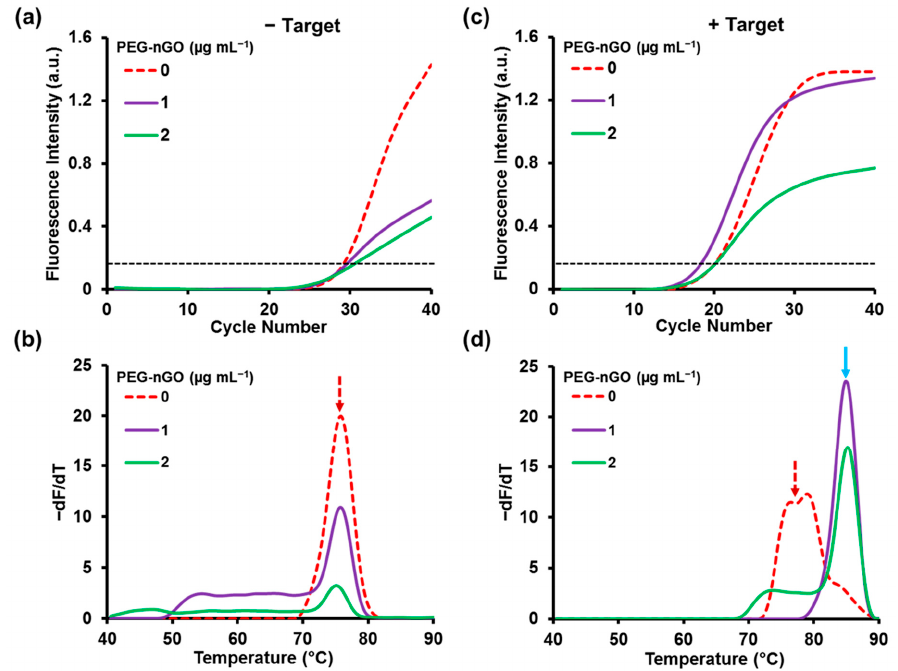
Figure 3. Effect of PEG-nGO on specificity of EG-based qPCR. ( a ) Real-time fluorescence monitoring of qPCR-amplified products in the absence of target RNA (IFZ B) with various PEG-nGO concentrations (0, 1 and 2 μ g mL − 1 ). ( b ) Melting curve analysis of qPCR-amplified products in the absence of target RNA with various PEG-nGO concentrations (0, 1, and 2 μ g mL − 1 ). ( c ) Real-time fluorescence monitoring of qPCR-amplified products in the presence of target RNA with various PEG-nGO concentrations (0, 1 and 2 μ g mL − 1 ). ( d ) Melting curve analysis of qPCR-amplified products in the presence of target RNA with various PEG-nGO concentrations (0, 1 and 2 μ g mL − 1 ). Red dotted arrow and cyan arrow represent nonspecific- and specific-amplicon dsDNA peak, respectively.